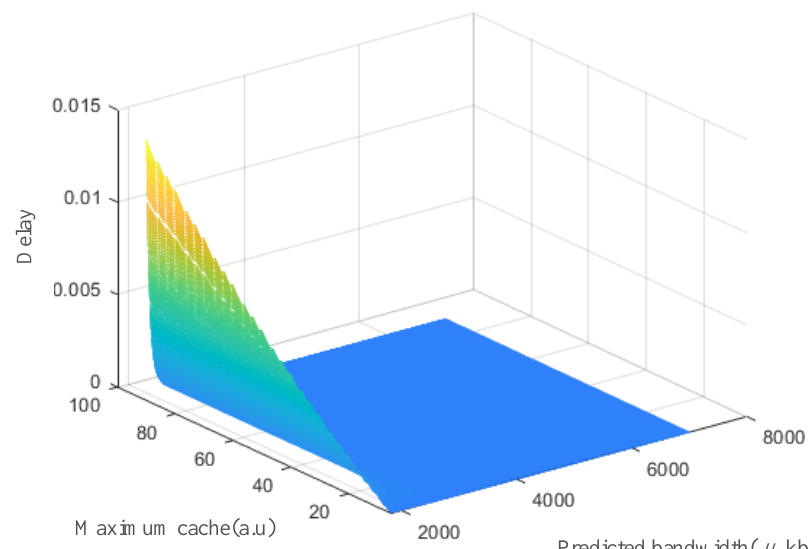
Figure 4. Delay performance analysis of queuing system.